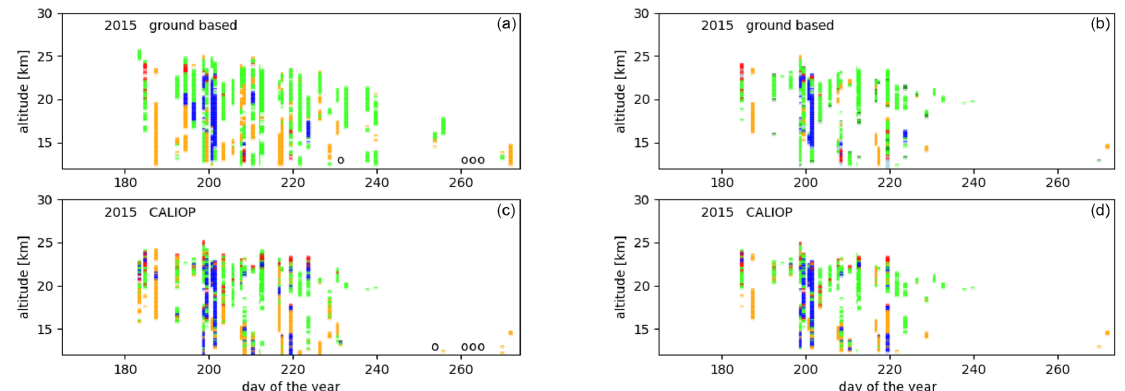
Figure 4. All quasi-coincident observations (a, c) and only those where PSCs were observed by both lidars (b, d) for 2015 above Dome C. (a, b) Ground-based lidar. (c, d) CALIOP above Dome C. The different colors indicate PSCs of different composition. Green: NAT mixtures; yellow: STS; red: enhanced NAT mixtures; blue: ice. The circles indicate measured profiles without PSCs.